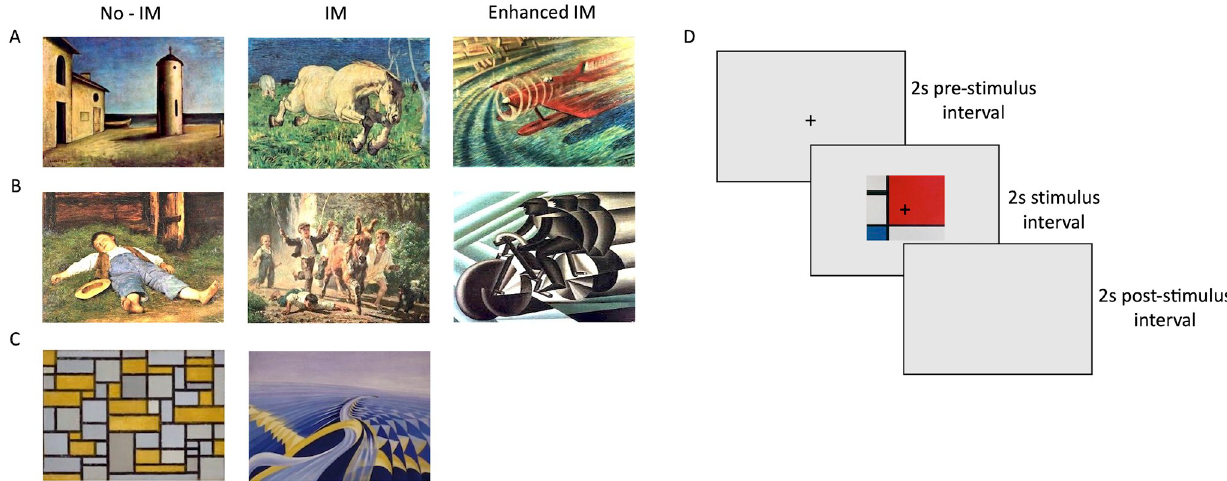
Fig 1. Paintings’ categories and procedure. (A) Examples of figurative paintings representing objects or animals. From left to right: Dopo il tramonto (Carr à , 1927); Cavallo al galoppo (Segantini, 1858); Idrovelocità : folgore rossa (Sansoni, 1935); (B) Examples of figurative paintings representing humans. From left to right: Sleeping boy in the bay (Anker, 1891); Monelli di strada (Palizzi, 1872); Ciclista (Depero, 1922); (C) Examples of abstract paintings. From left to right: Composizione con grigio e ocra (Mondrian, 1918); Velocità di motoscafo (Cappa Marinetti, 1922). Paintings shown are in the public domain. Copyright laws prohibit reproduction of all paintings used as stimuli, but they can be viewed on the web using the links reported in S1 List. (D) Schematic representation of a trial. (2 sec) of movies, containing squares of different colors moving right-to-left of left-to-right on a grey background, purposedly created by the authors.